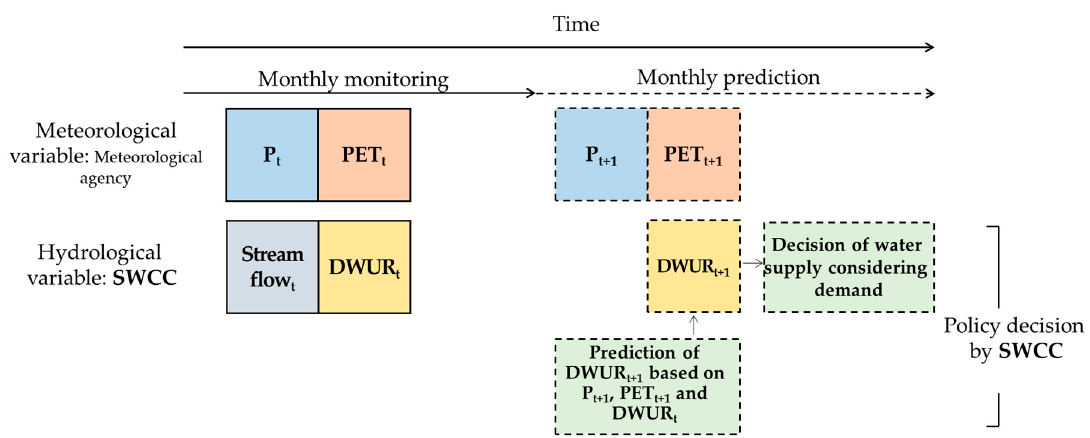
Figure 10. Monitoring and decision making by the stream water coordination council (SWCC).